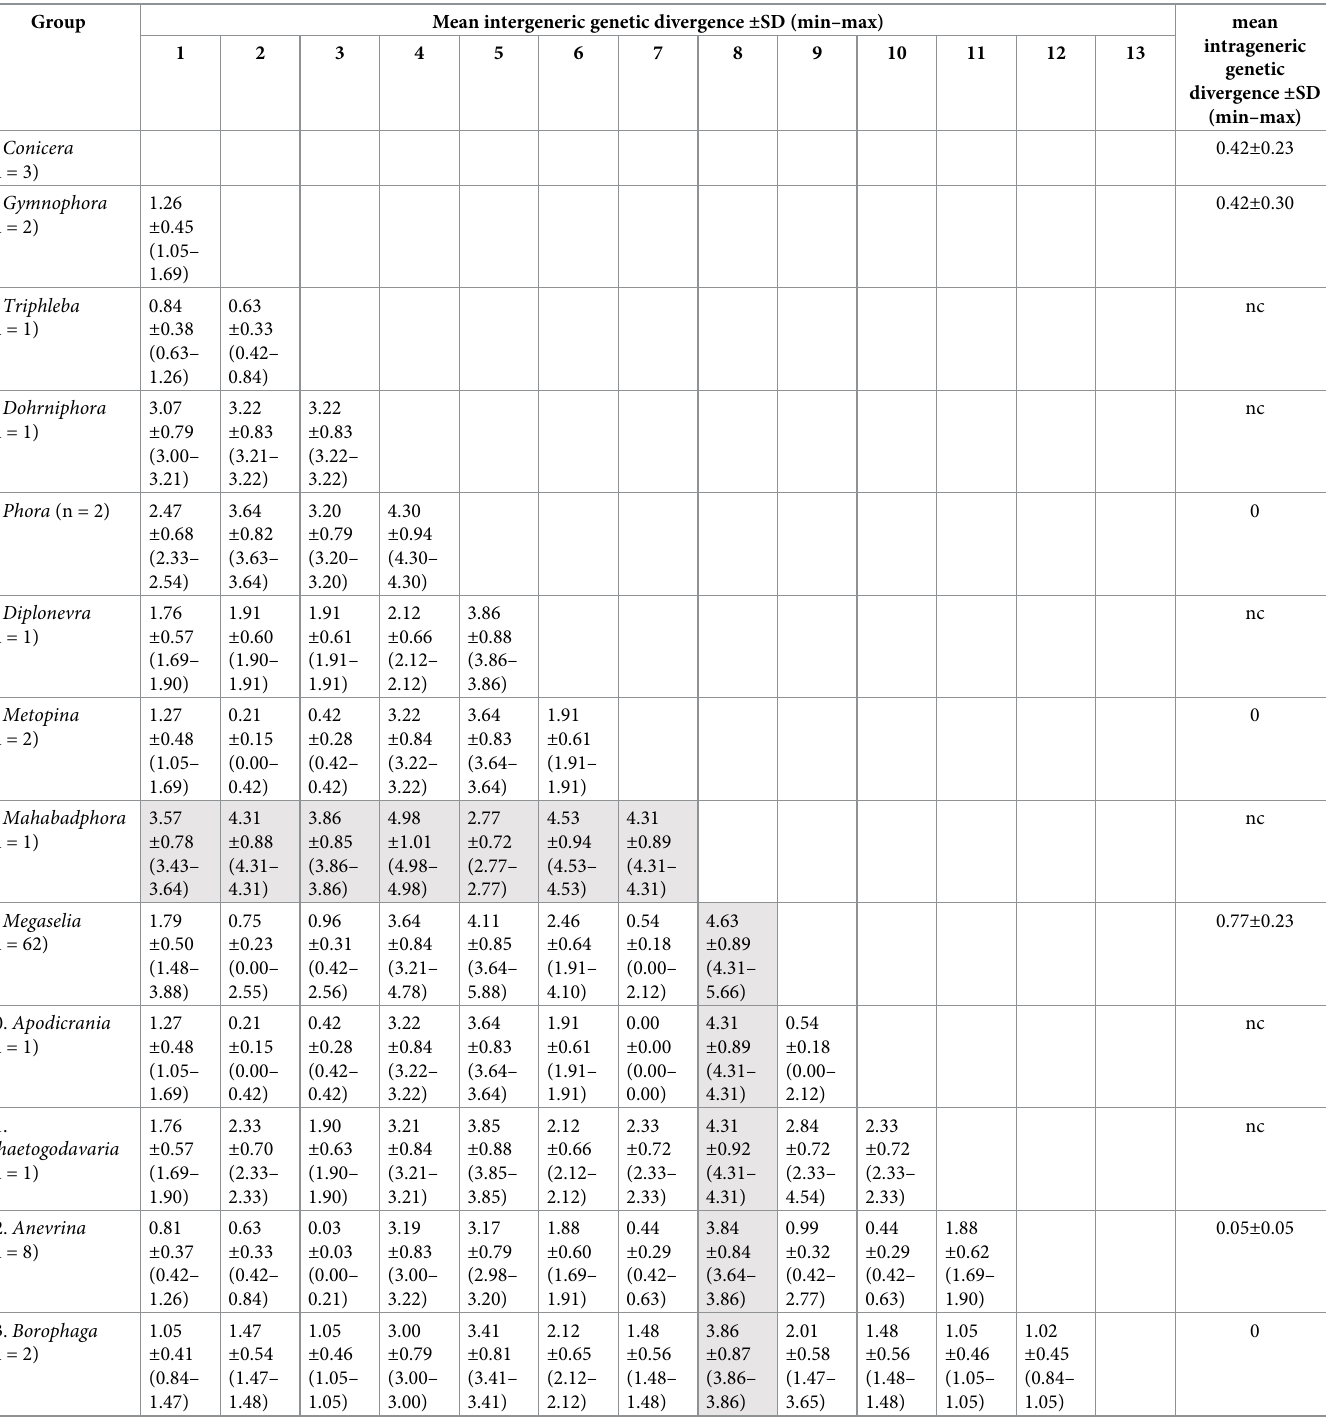
Table 4. K2P genetic distances ± standard deviations (SD) for studied scuttle flies genera based on 481–549 bps of 28S rRNA sequences.